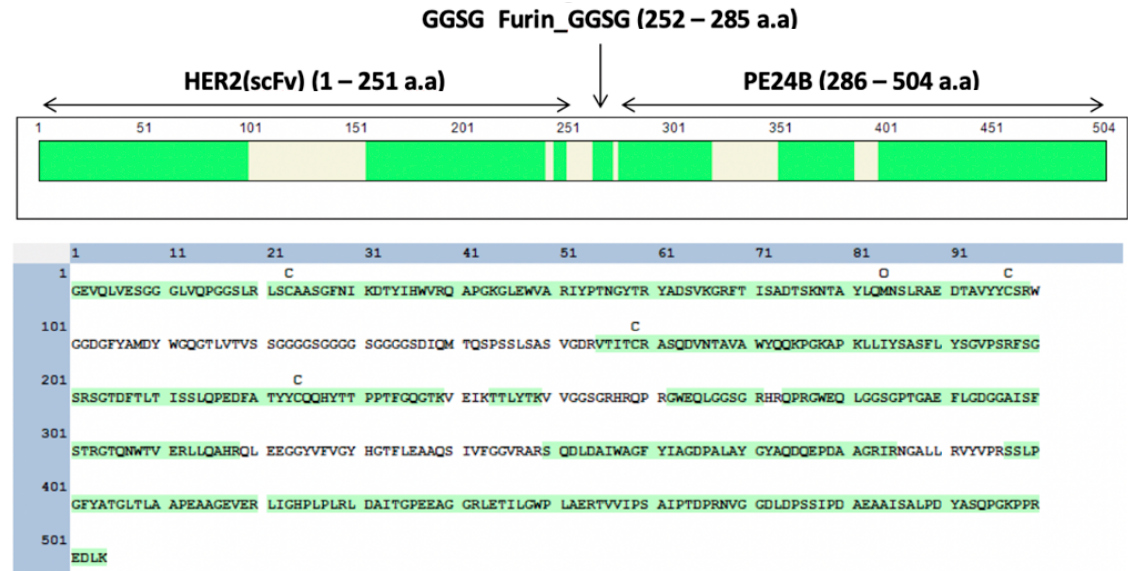
Figure 5. LC-MS/MS analysis for verification of HER2(scFv)-PE24B. HER2(scFv)-PE24B was digested by trypsin before mass analysis. The percentage coverage for peptide identification was 77.2%. The identified fragments are colored